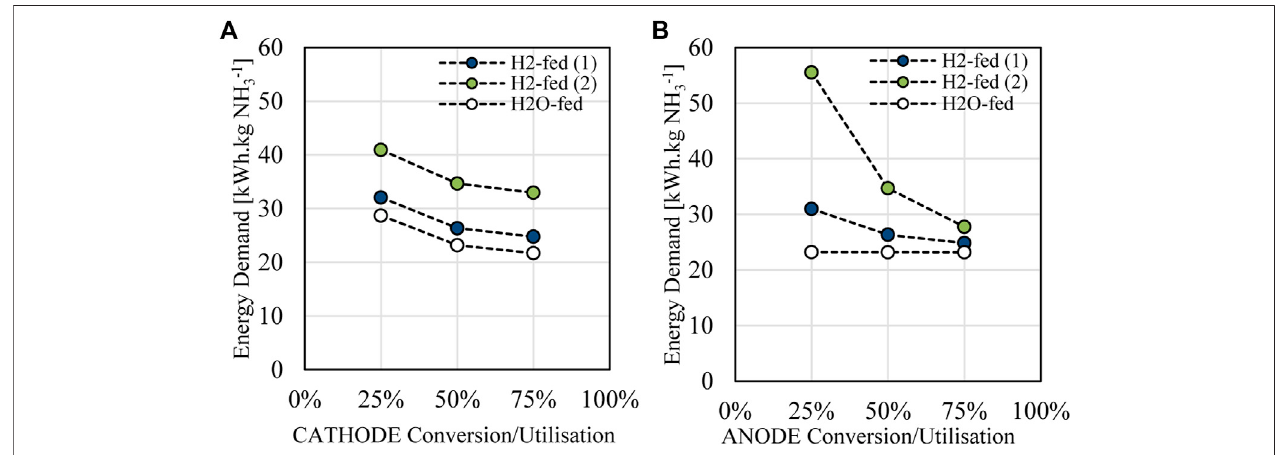
FIGURE 11 | Conversion/utilisation (in mol% of inlet reactants) impact on total process energy demand for (A) cathode and (B) anode conversion.